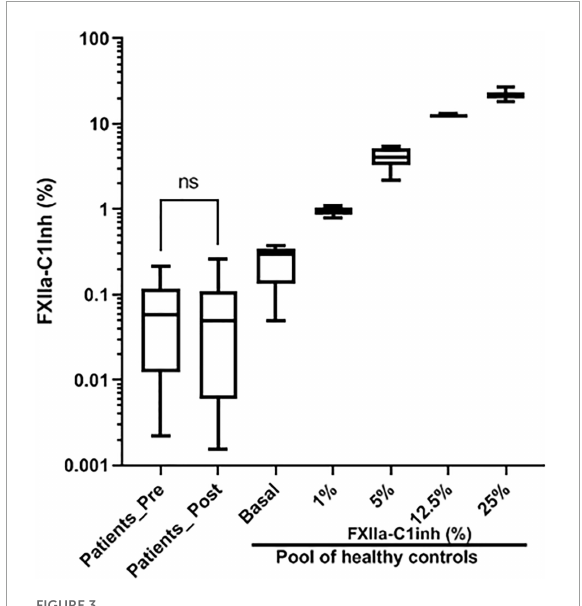
FIGURE3 Levels of FXIIa-C1 Inhibitor complexes in pre- and post-procedure samples. Values, referenced as percentages of kaolin-full activated reference pool plasma generated 100 healthy subjects, were determined by a specific ELISA using nanobodies. ns: p >